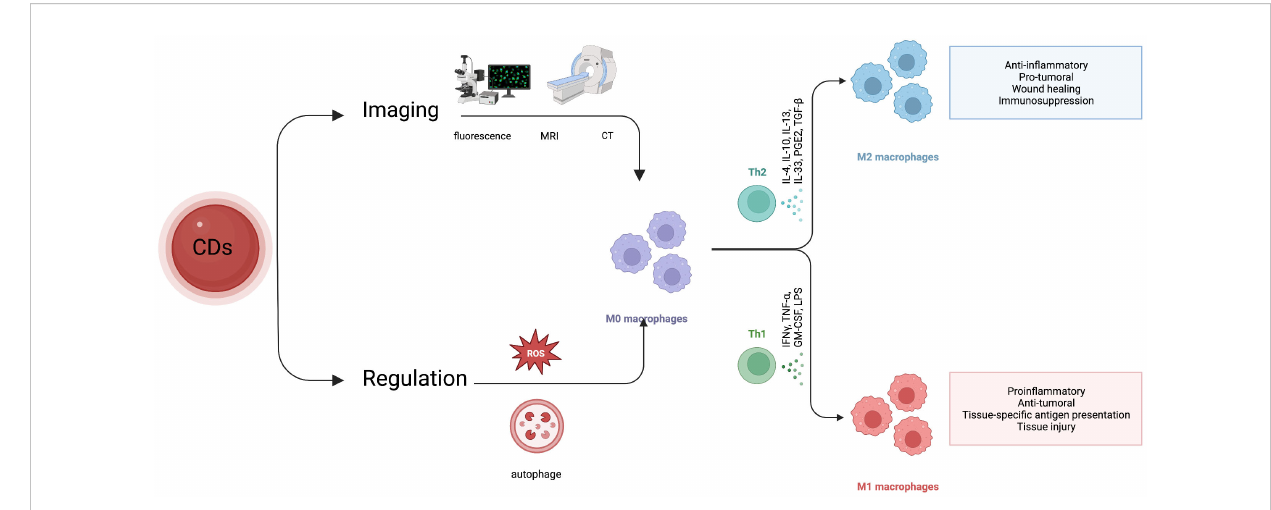
SCHEME 3 Application of carbon dots in macrophage imaging and